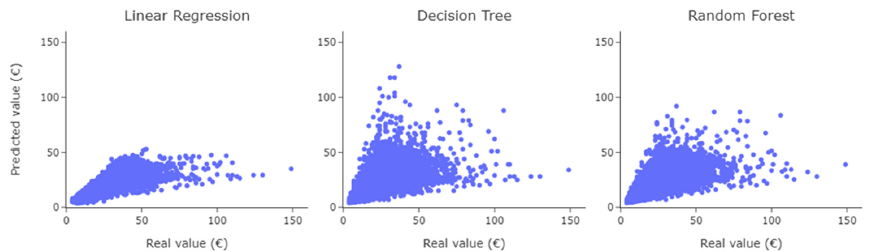
Figure 6. Sca tt erplots of real fare values versus predicted values. Figure 6. Scatterplots of real fare values versus predicted